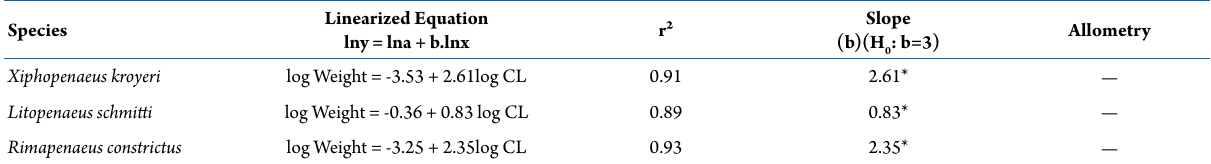
Table 1. Weight x length relationship of three Penaeidae species [seabob shrimp ( Xiphopenaeus kroyeri ), white shrimp ( Litopenaeus schmitti ), roughneck shrimp ( Rimapenaeus constrictus )], sampled in Ubatuba, São Paulo, Brazil. Values with * were statistically significant from isometry (b = 3) ( p < 0.05).